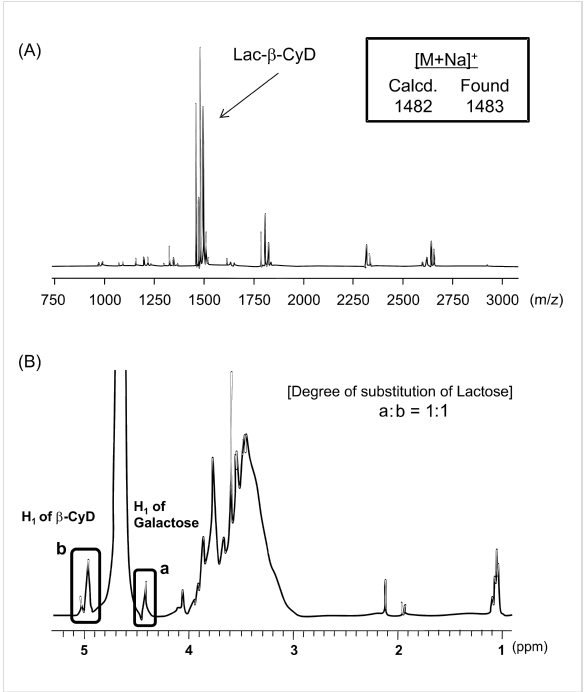
Figure 2: MALDI–TOF MS (A) and 1 H NMR (B) spectra of Lac- β -CyD.